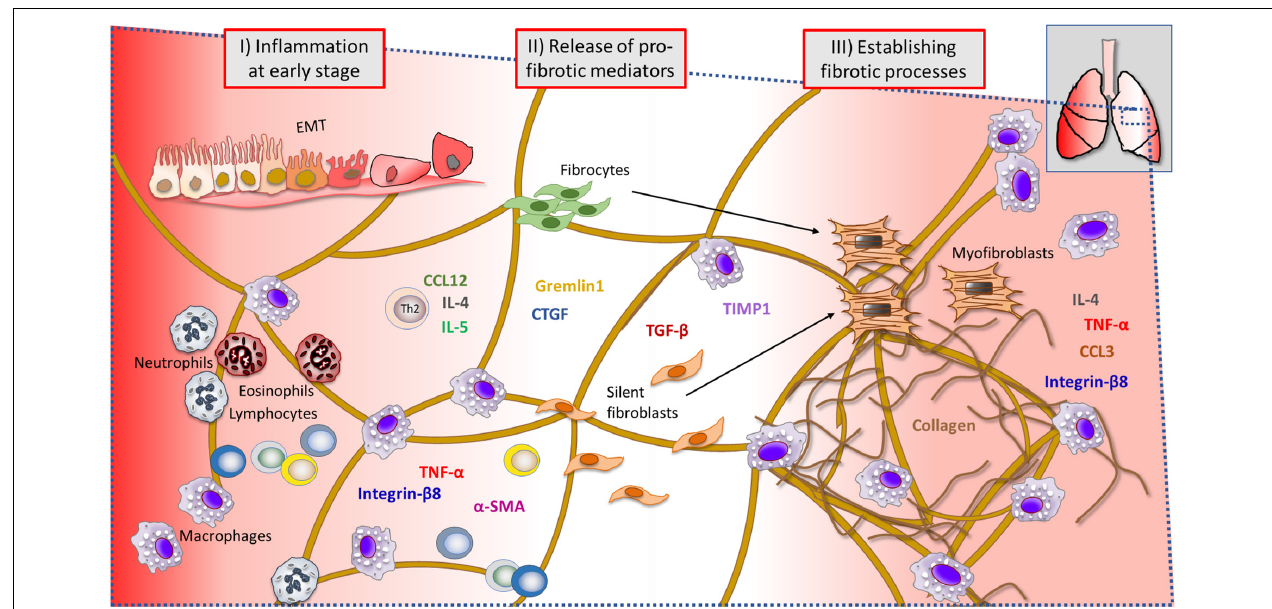
FIGURE 10 | Summary of events during ongoing lung injury, with related cells and markers involved at the injury site of the lung tissue. Immune cells and gene markers that were analyzed throughout this study are presented in a probable scenario during lung injury, at a microscopic viewed site within the lung tissue. The early phase of bleomycin-triggered injury induced immune cell activation and infiltration, observed significantly elevated at day 3–7 post challenge (I). Simultaneously, inflammatory cytokines and pro-fibrotic markers assessed to be significantly increased at this point were several important markers known to be involved in driving the fibrosis progression (II). The assessed lesions by histology, indicated collagen-rich sites and dense fibrotic lesions, also evident by MRI and PET imaging. The later time points (III) indicated a second phase of macrophage infiltration (day 28) in BAL, while several genes were upregulated in particular during the last day of this model (EMT, epithelial–mesenchymal